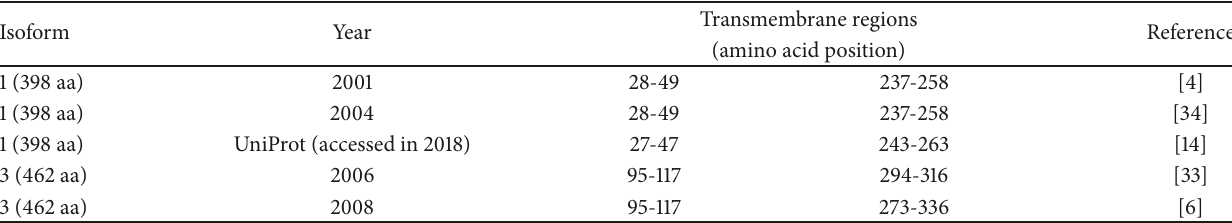
Table 1: Transmembrane regions of